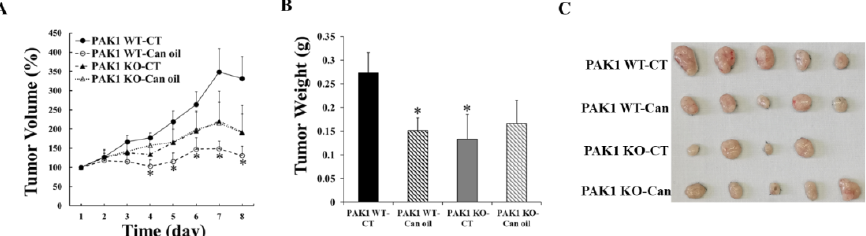
Figure 3. PAK1 knockout blocked the inhibition of cannabis oil on pancreatic tumour growth. Murine pancreatic cancer (PC) cells were subcutaneously injected into the flanks of PAK1 wild type (WT, n = 10) and knockout (KO, n = 9) male mice (8-week old). After 5 days of tumour cell injection and when the average tumour volumes reached 50 mm 3 , cannabis oil (Can-oil) containing CBD and THC with 1:1 ratio, was given orally every day for 8 days. Tumour volumes ( A ) were measured daily and tumour weight ( B ) was determined at the end of the experiment. ( C ): photos of tumors dissected at the end of the experiment. CT: control, Can: cannabis oil, Can-oil: cannabis oil. *, p < 0.05 compared to non-treated PAK1 WT control.